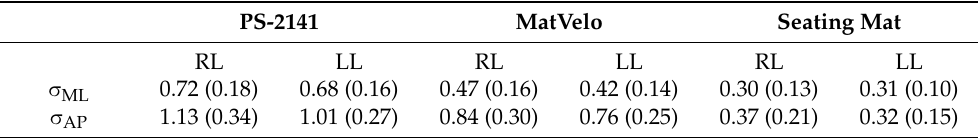
Table 2. σ ML and σ AP in cm for the two trials and three instruments, given as mean(SD), where σ ML is the standard deviation of the medial–lateral (ML) components of the CoP, σ AP is the standard deviation of the anterior–posterior (AP) components of the CoP. RL, right-leg trial; LL, left-leg trial. PS-2141 MatVelo Seating Mat